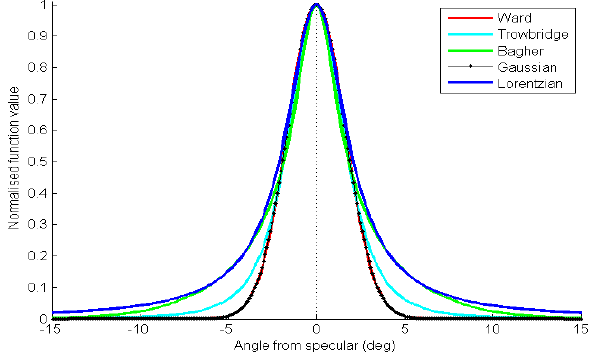
Figure 16. Five specular functions of